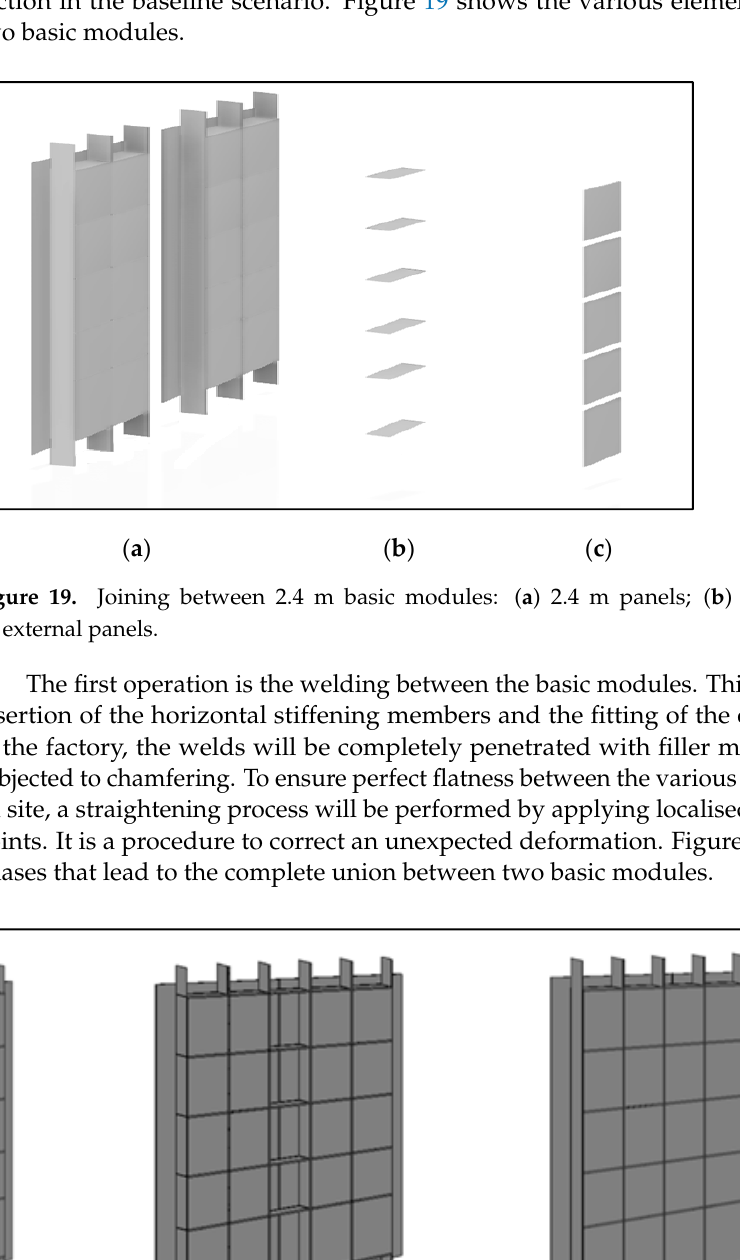
( c ) Figure 21. Assembly of the DV as simulated by Navisworks: ( a ) panel transport in the experimental area; ( b ) panel lifting by means of the bridge crane; ( c ) panel assembly at the location of the SHIP detector.